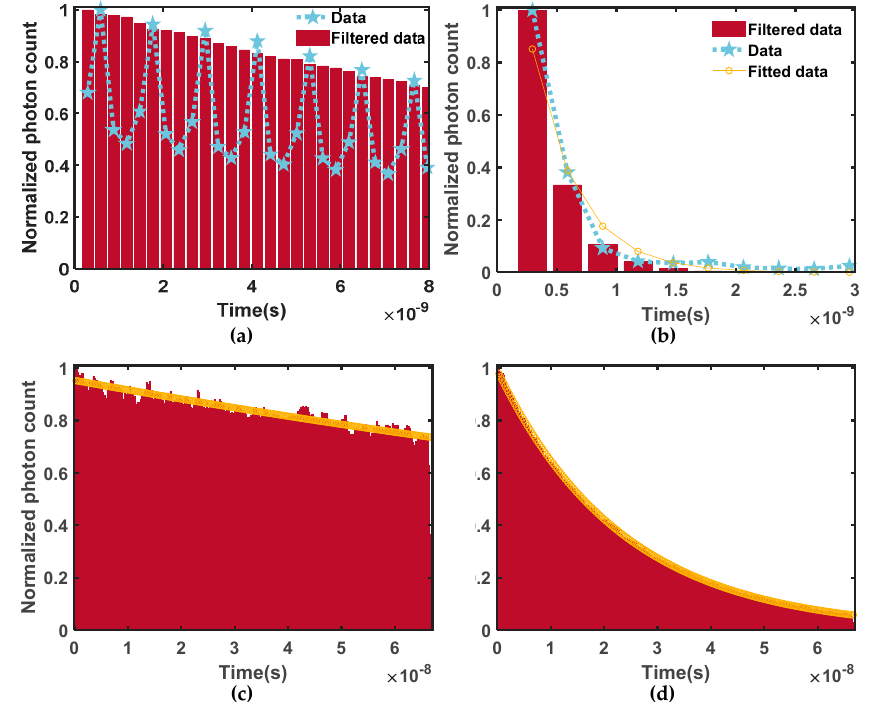
Figure 3. Histogram of the photon arrival time at different illumination levels (plots are normalized individually to the corresponding maximum value t exp = 30-ms): ( a ) moving average filters the nonlinearity; ( b ) matching between raw, filtered, and fitted data at high photon flux; ( c , d ) fitted data are aligned to the filtered data at low and medium flux.